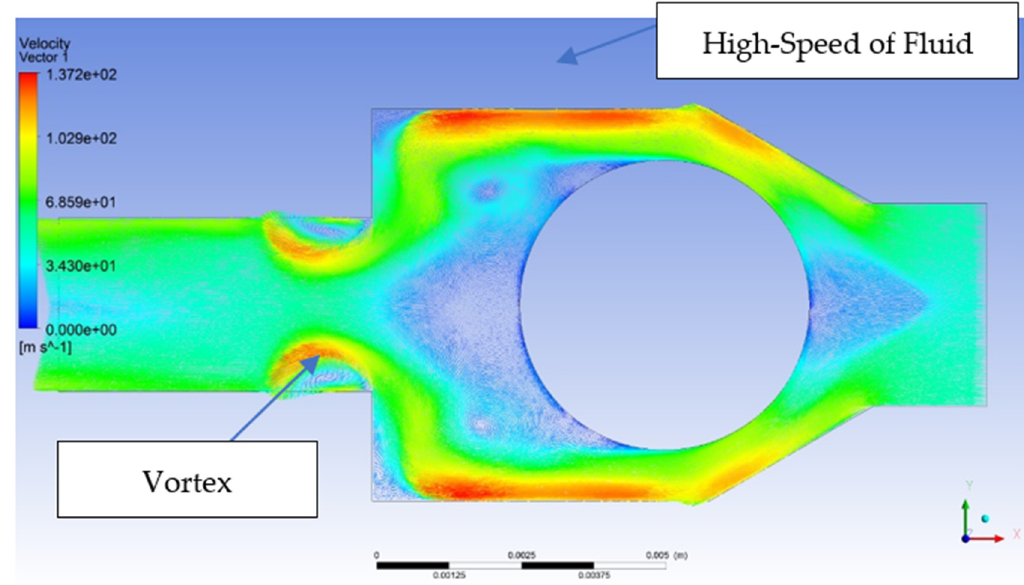
Figure 16. Velocity CFD: Spherical Seat Valve − x = 1.005 [mm], pdn = 2000 [bar] and pup = 2100 [bar].